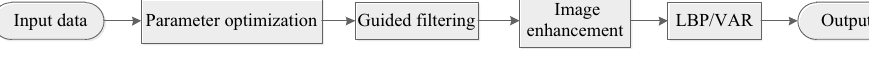
Fig. 2 Calculation flowchart for the proposed algorithm Input data Parameter